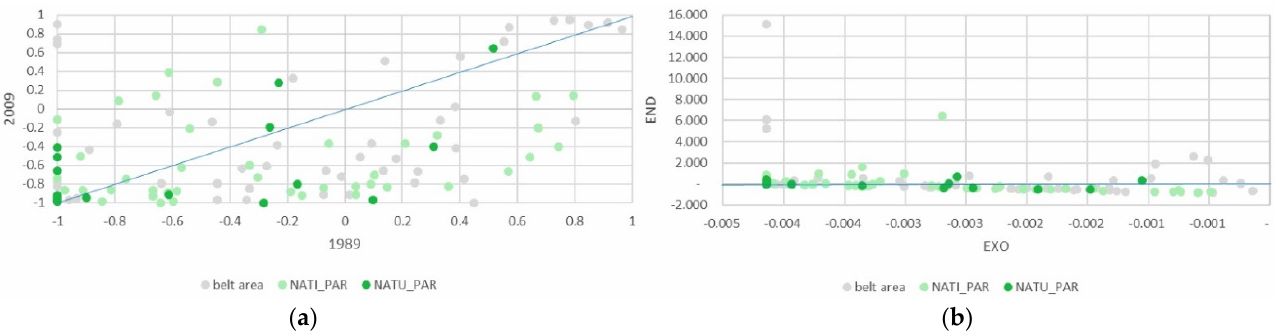
Figure 6. ( a , b ) Sierra Nevada- PSI and DPSI for vegetable cultivation. Source: Drawn up by the authors using data from the 1989 and 2009 Agrarian Censuses, Ministry of Agriculture.